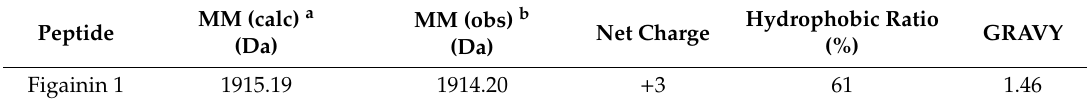
Table 1. Biophysical properties of Figainin